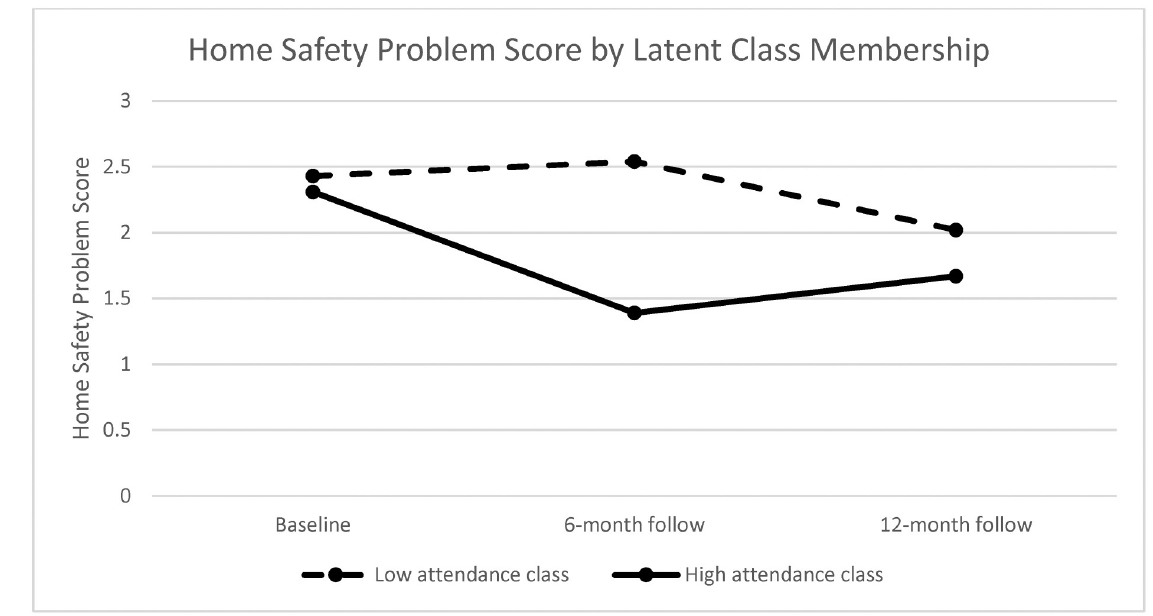
Fig 2. Home safety problem score at each assessment by latent class